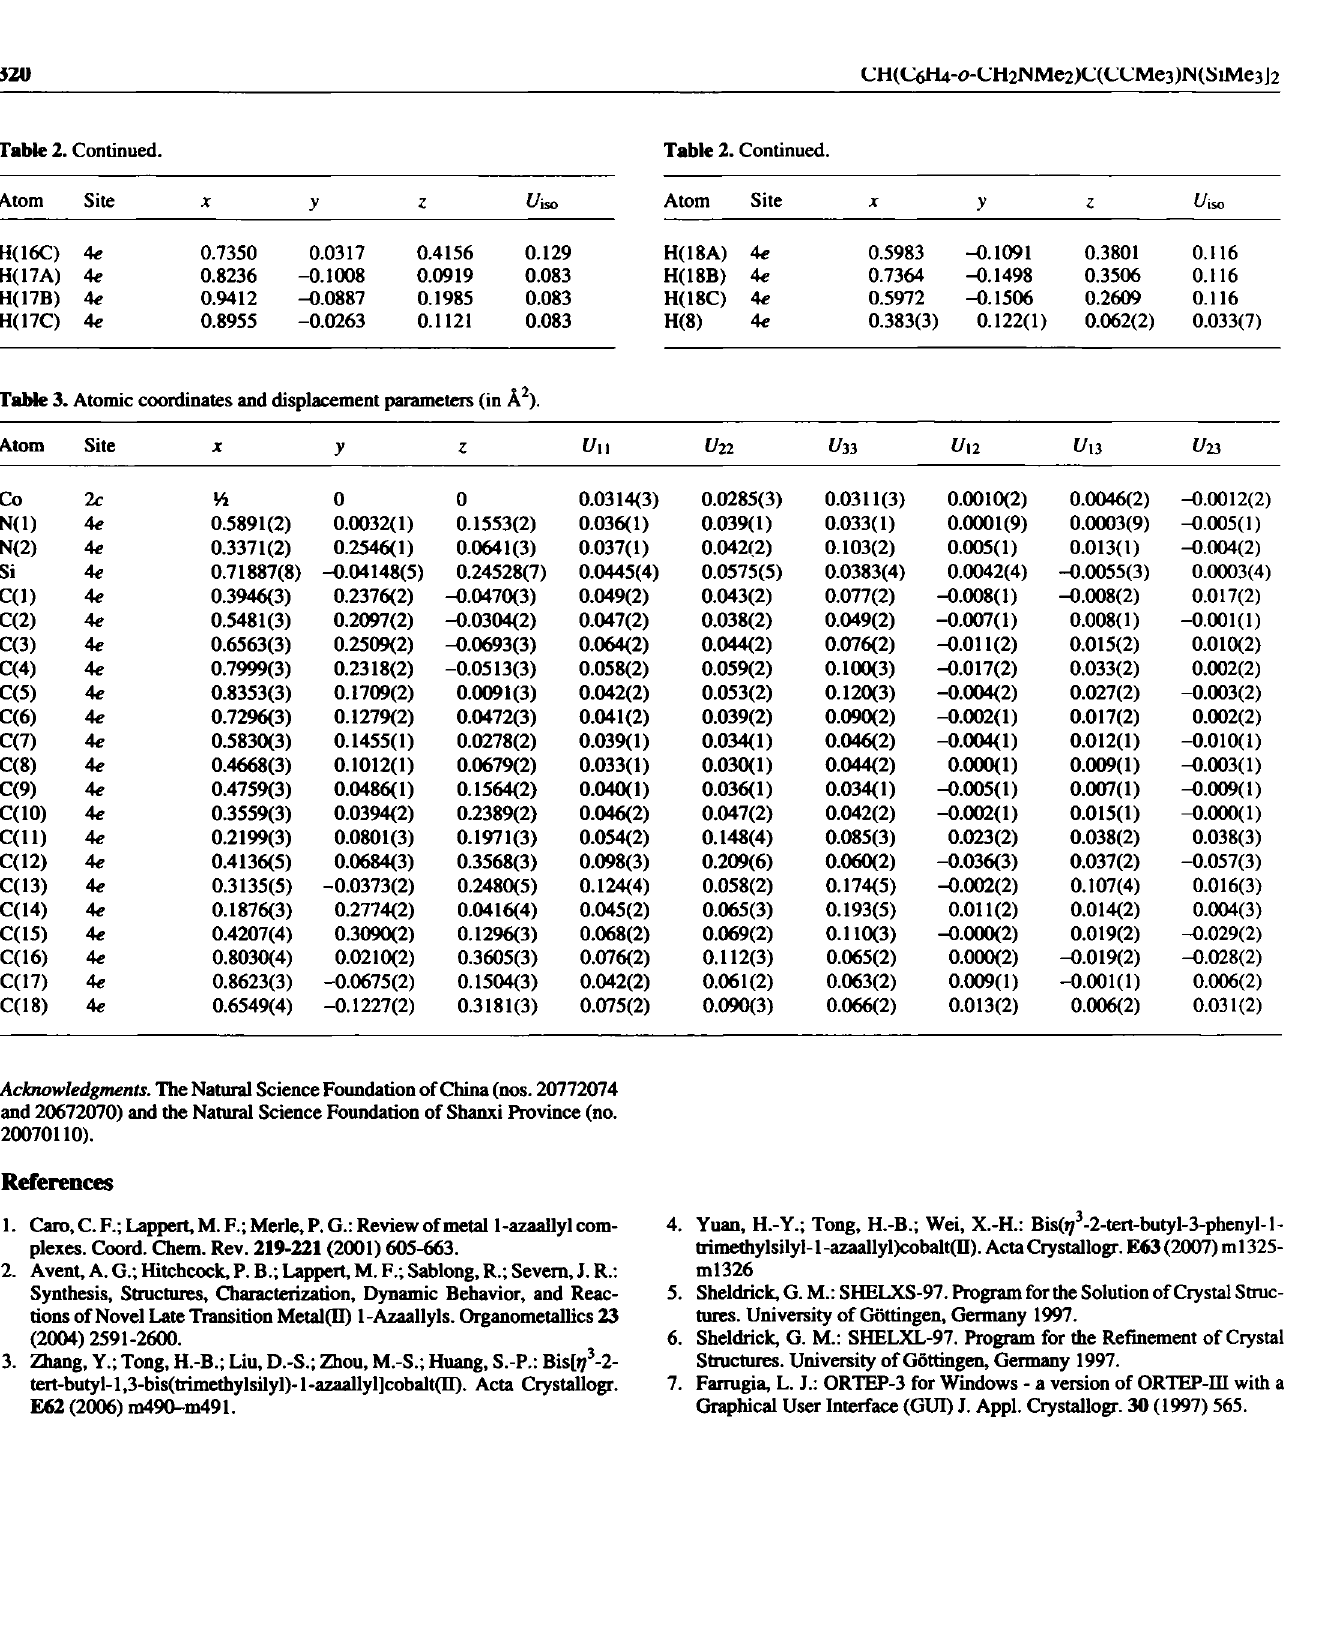
Table 3. Atomic coordinates and displacement parameters (in Â 2